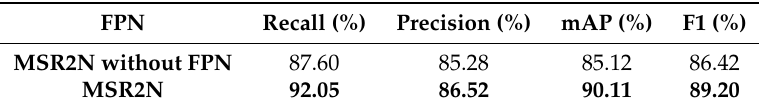
Table 5. Experimental results of